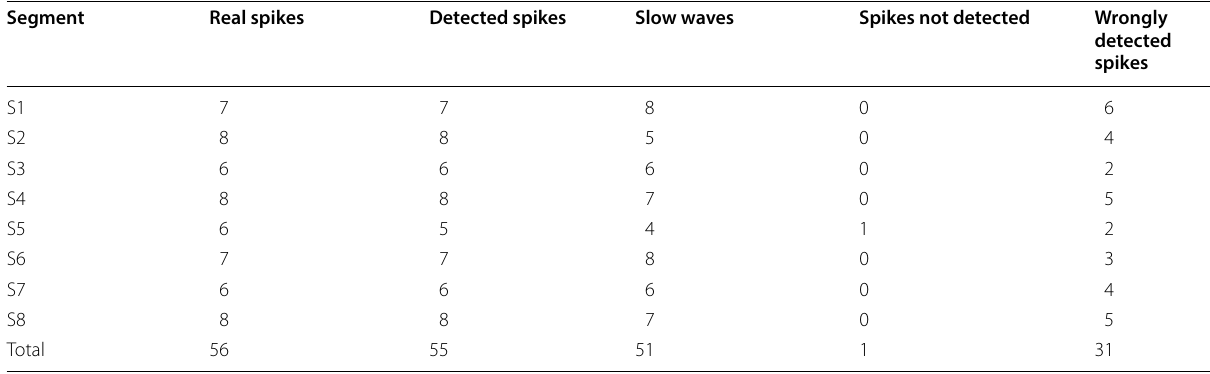
Table 2 Results of the evaluation using threshold 0.7 Segment Real